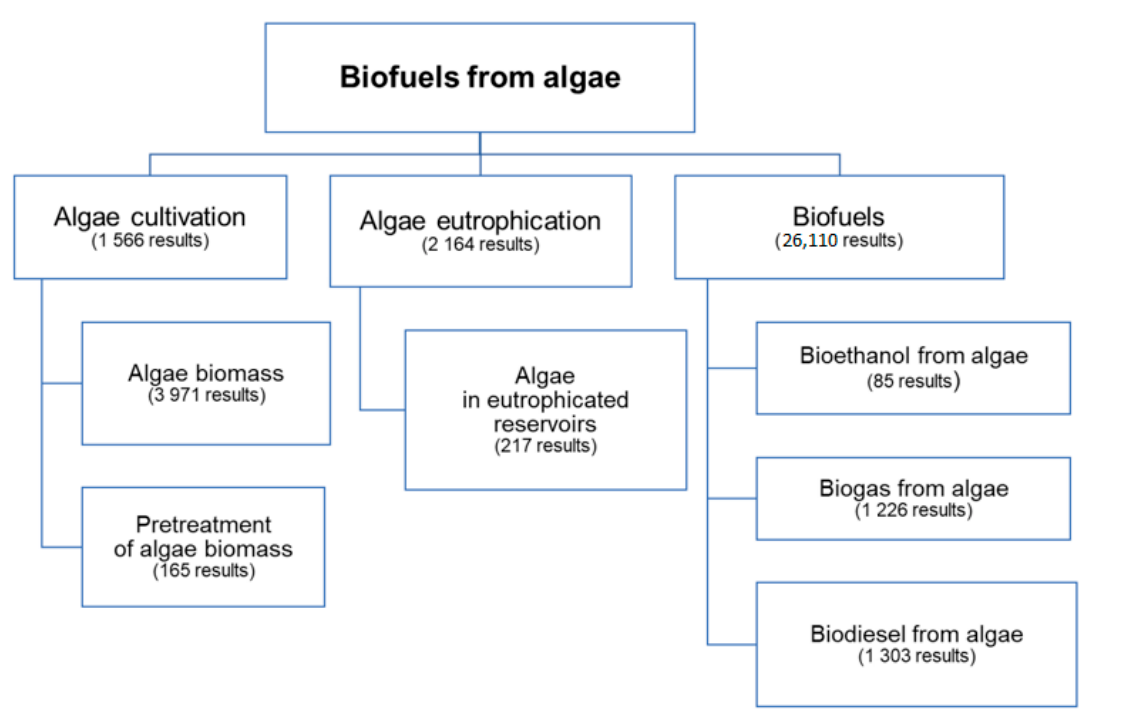
Figure 2. A diagram for the identification of peer-reviewed papers included in PubMed taking into account different keywords.